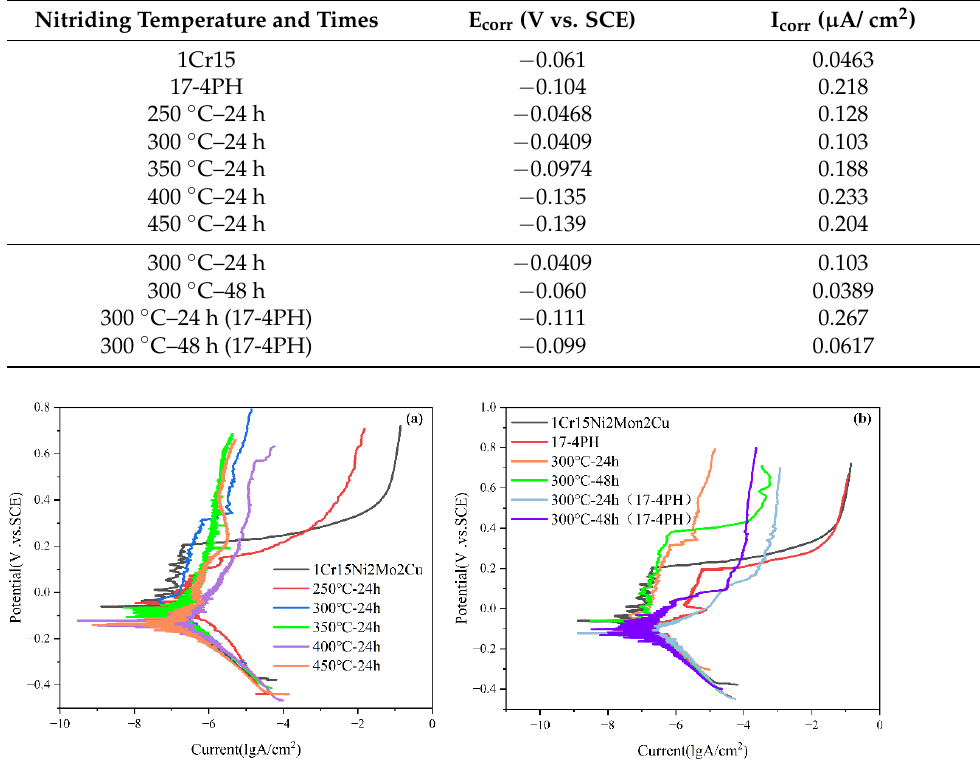
Table 6. Relevant electrochemical parameters calculated by Tafel fitting. Nitriding Temperature and Times